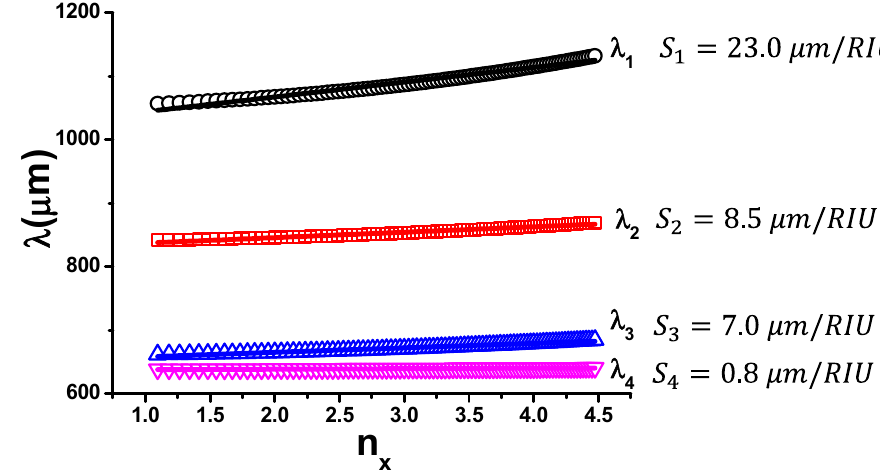
Figure 5. Data points display the resonance frequencies vs, n x retrieved from Figure 4b expressed in terms of wavelength λ i = c / f i . Full lines represent the linear fits providing the sensitivity values S i for each curve.